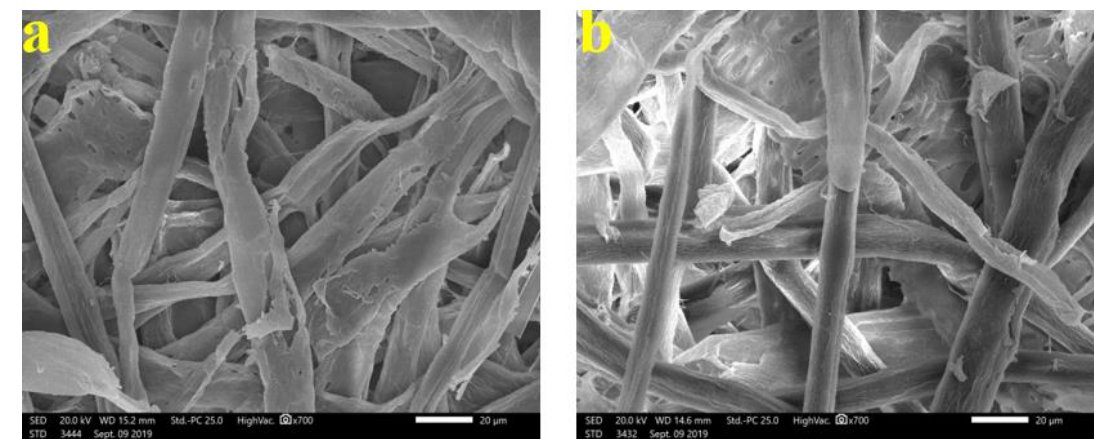
Figure 12. SEM images show inhibition of fungal growth on E. camaldulensis WB pulp paper manufactured with HeOE additives and inoculated with A. flavus : ( a ) with M. azedarach HeOE at 5%; ( b ) with S. alba HeOE at 5%.